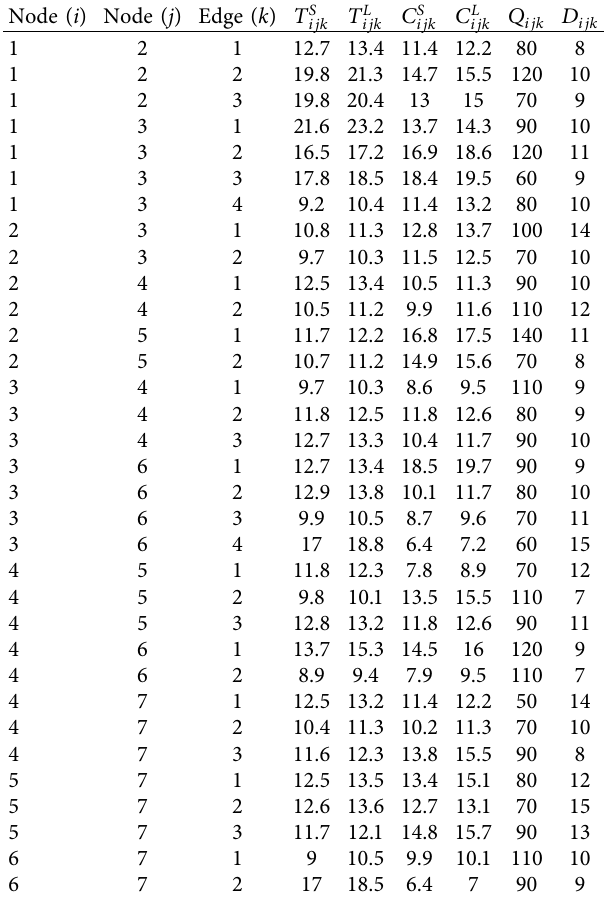
Table 3: Basic data of edges for example